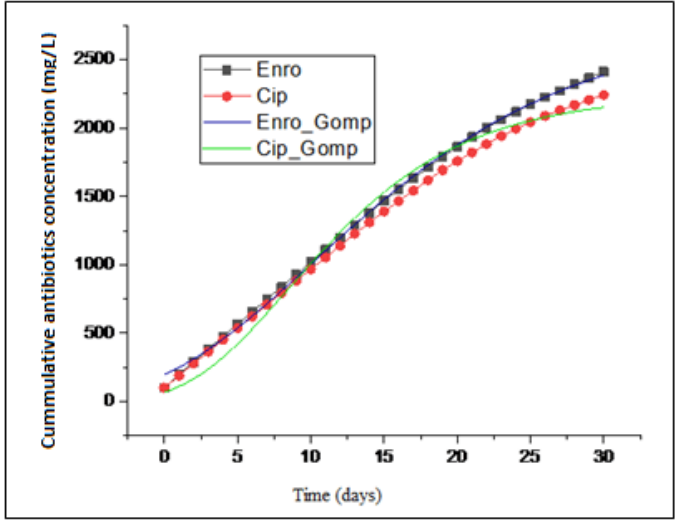
Figure 4. Data fitting of ENRO and CIP biodegradation to Gompertz model. 154